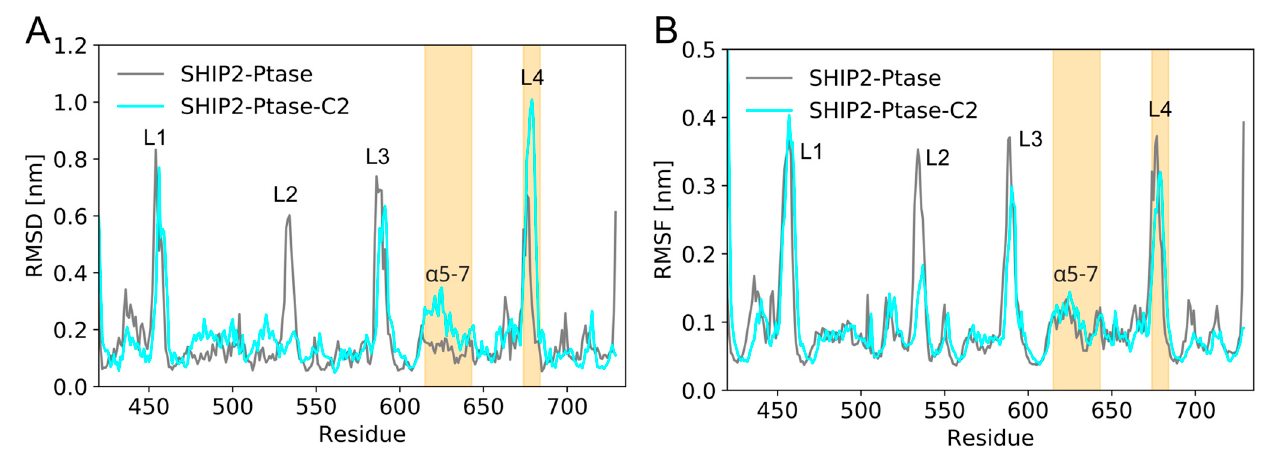
Figure 6. RMSD and RMSF of all-atom simulations of full-length SHIP2 and Ptase SHIP2 : ( A ) RMSD of the Ptase section are calculated per residue as time average over the 600 ns simulations, with respect to the binding poses at 0 ns for Ptase SHIP2 (grey) and full-length SHIP2 (Ptase-C2, cyan). Loop L4 (residues 674–684) and helices α 5-7 (residues 615–643) are highlighted in orange. ( B ) Corresponding RMSF.